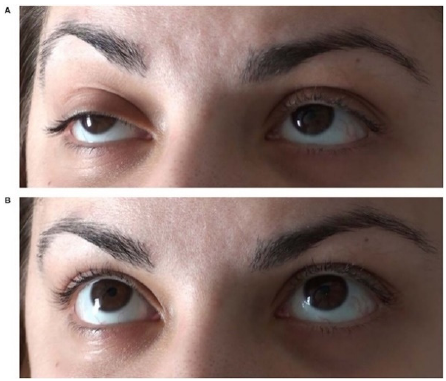
Figure 1. “Mainly right-sided oculomotor paresis with elevation deficit and ptosis ( A ) responded positively to an intravenous test dose of 9 mg edrophonium chloride ( B ), suggesting that double vision was caused by ocular manifestation of myasthenia gravis.”